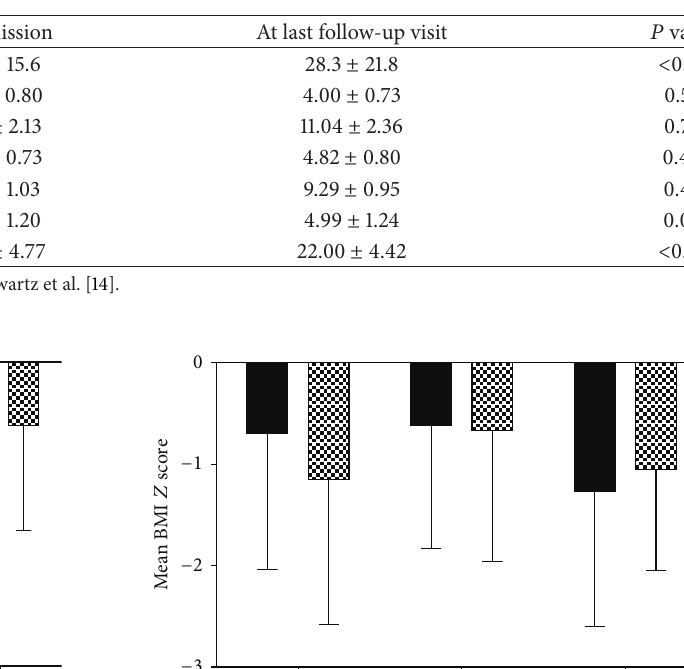
Table 1: Clinical and laboratory data at admission and at last follow-up visit.